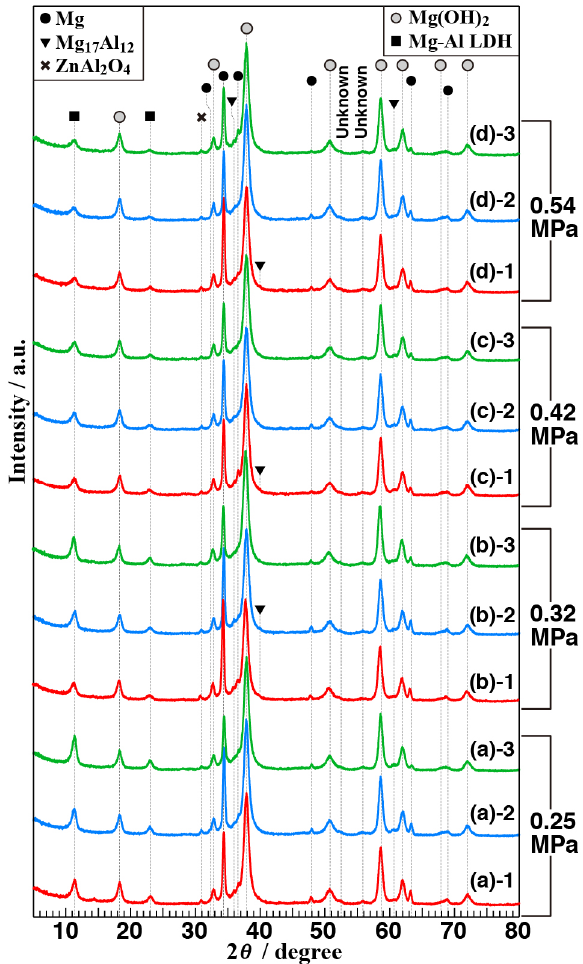
Figure 7. GAXRD patterns of three sets of data per condition of the films formed on AZ61 by steam coating under different conditions: ( a ) 0.25, ( b ) 0.32, ( c ) 0.42, and ( d ) 0.54 MPa.